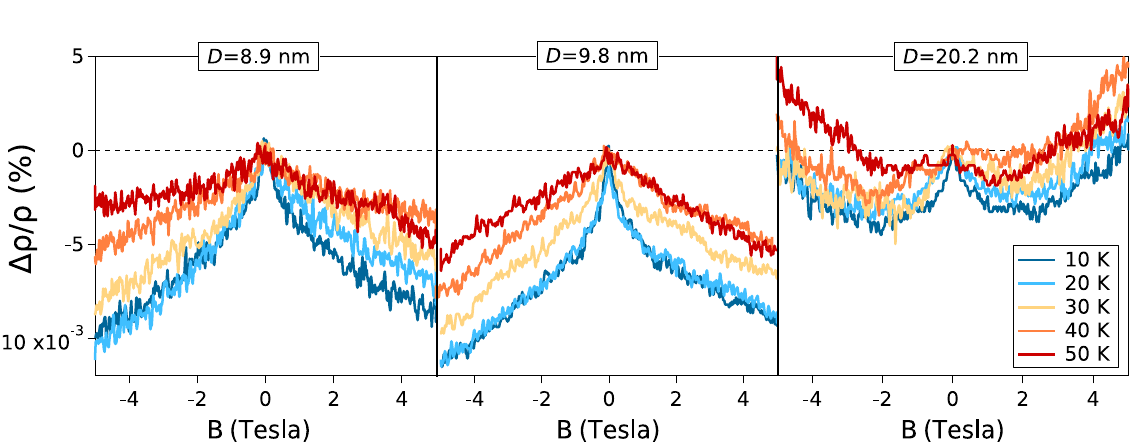
Figure 4. Temperature dependence of the magnetoresistance of the samples for D = 8.9 nm, 9.8 nm and 20.2